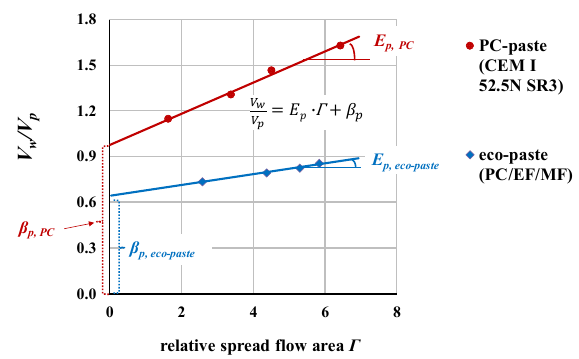
Figure 3. characteristic parameters β p (water demand at the onset of flow) and E p (sensitivity to water addition) of pure PC compared with eco‐ paste (PC/EF/MF).